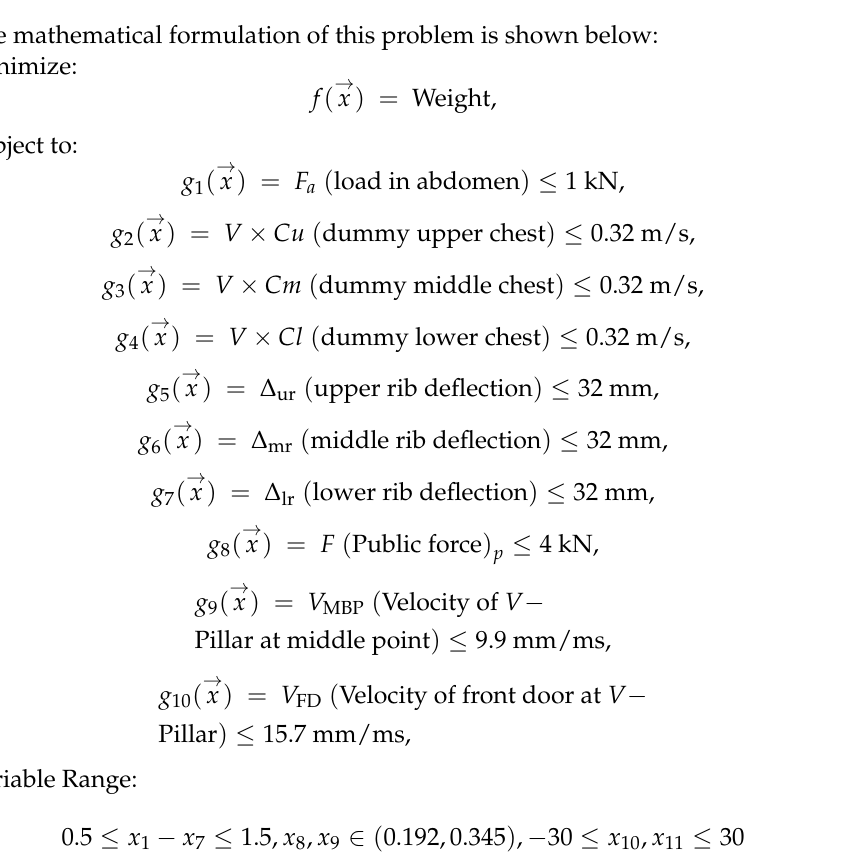
Figure 12. Car Crashworthiness